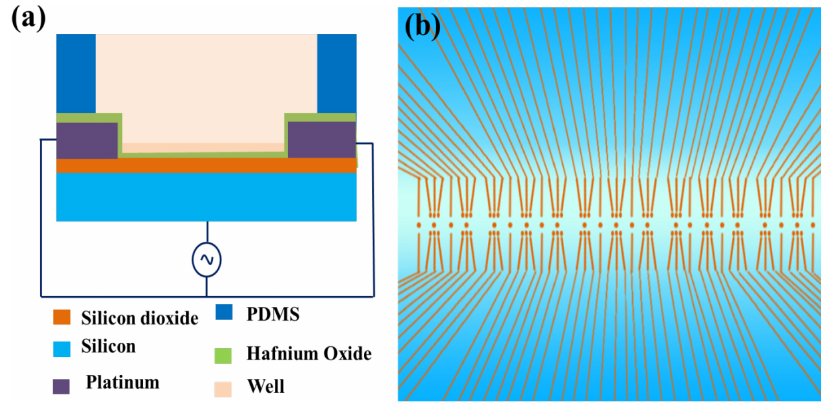
Figure 15. ( a ) Schematic diagram with electrical connection of the device and PDMS structure; ( b ) an array of transistors with nanowires and nanoribbons. Figure has been redrawn from reference